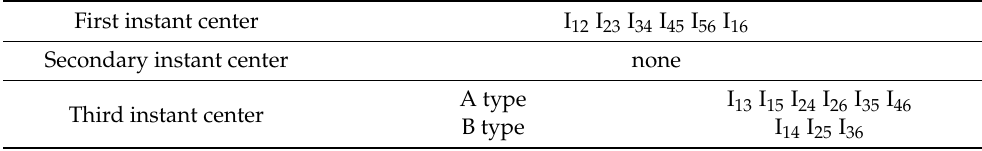
Table 5. Instant centers of six-bar planar linkage without virtual links.